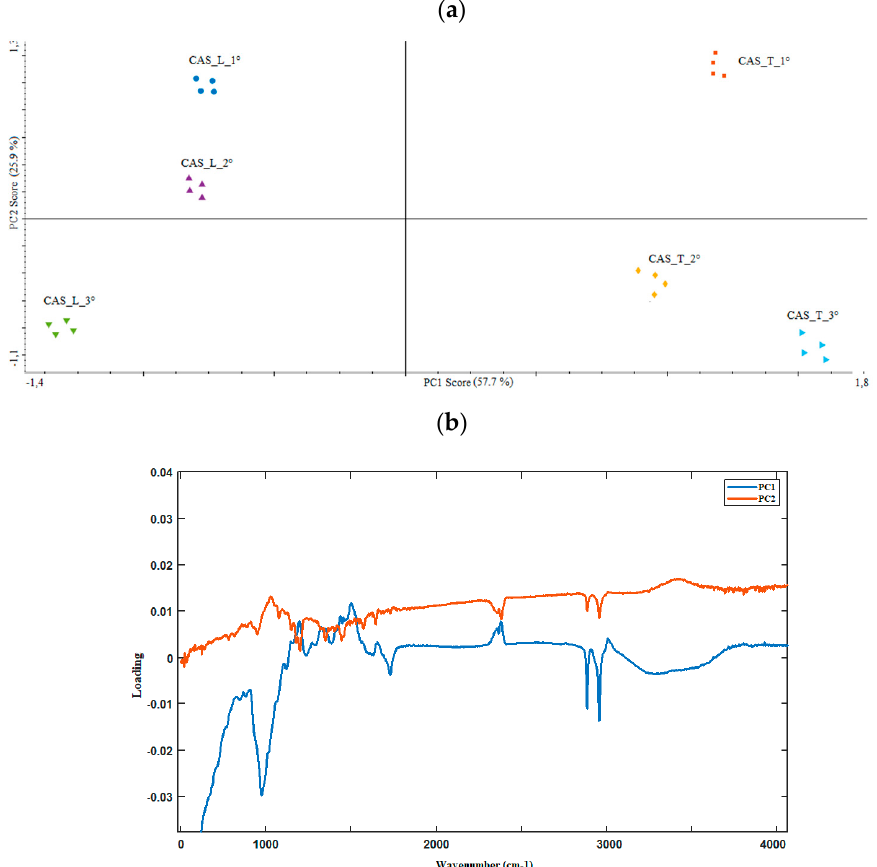
Figure 3. ( a ) PCA score plot of hop samples from different locations based on FTIR data matrix; ( b ) Loading plot of the spectral variables most contributing to the separation of hop samples on PC1 and